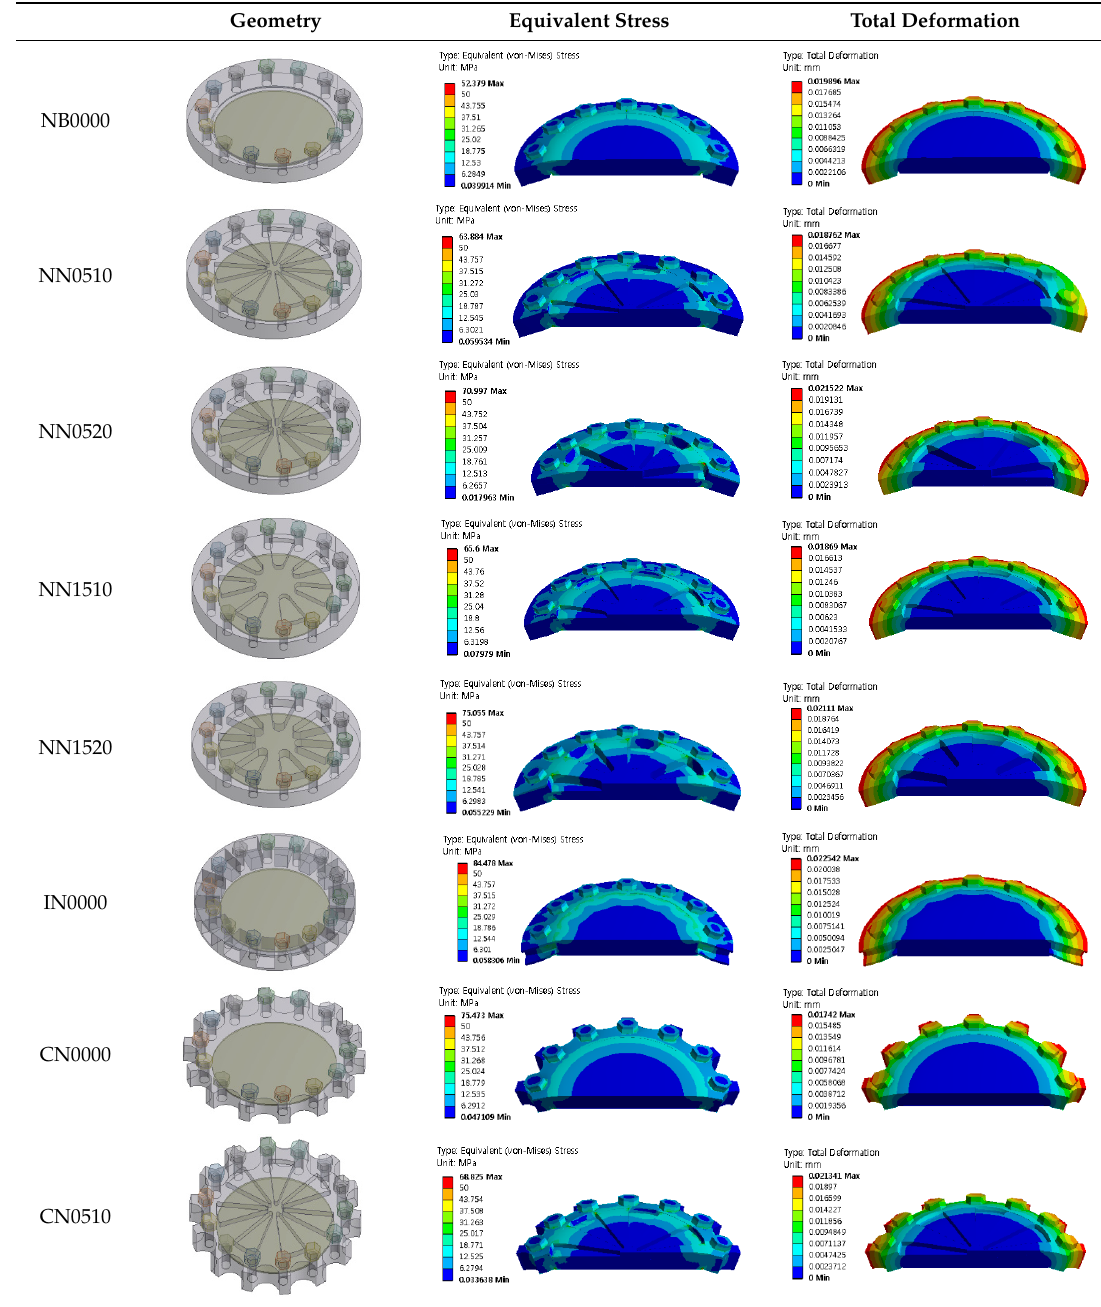
Table 3. Equivalent stress distribution and total deformation simulation results based on circular end plate geometry.